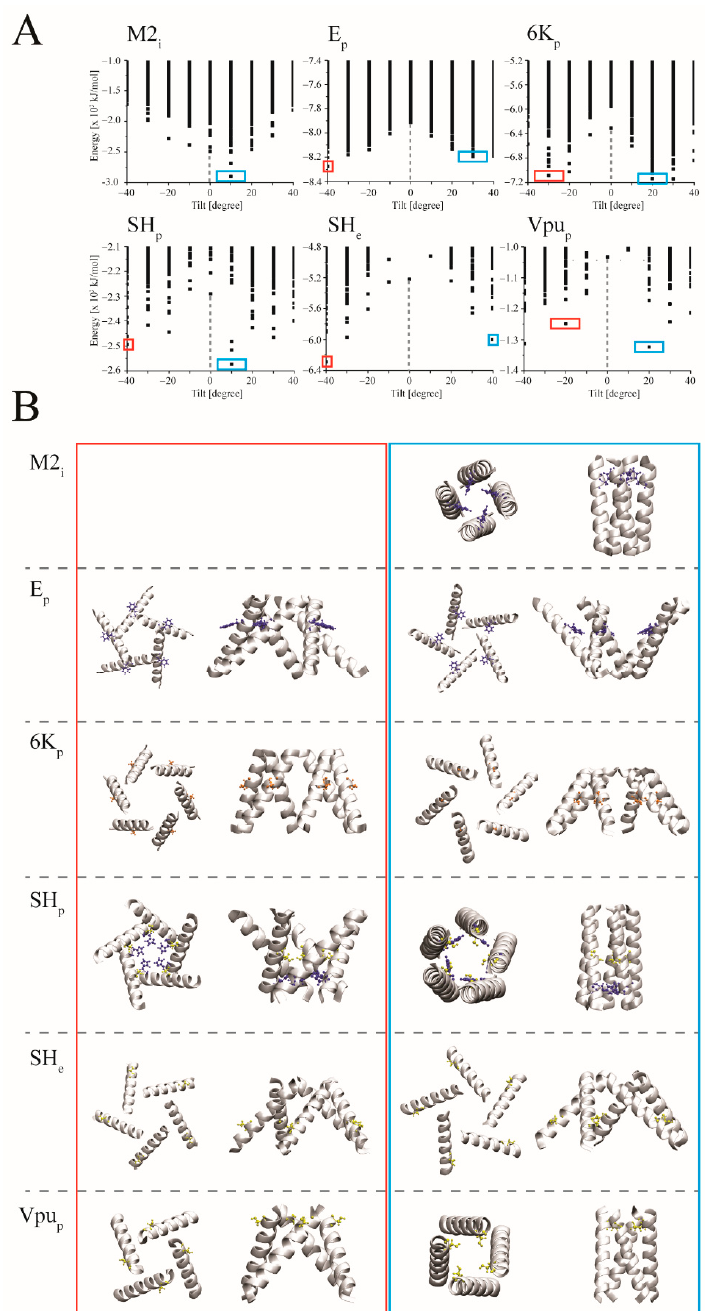
Figure 1. Ranking of the assembled all atom (AA) bundles over the tilt and selected structural models using S1 protocol. ( A ) The estimated binding energies (EBEs) of tetrameric bundles using ideal TMDs of M2 i and Vpu p , the pentameric bundles of E p , SH p , SH e , and the hexameric bundle of 6K p are plotted over the tilt. The grey dashed line marks the EBE for a zero tilt. The blue and red boxes mark minimum energies for energies with tilts larger and lower, respectively, than tilt values with zero tilt. ( B ) Structural models of the respective bundles marked with the red (tilt < 0 tilt) and blue boxes (tilt > 0) in top (from N to C) and side view (cytoplasmic side pointing downwards). The helix- backbone is shown in grey cartoon mode. Side chains mark the following residues: H37 for M2 and F26 for E, as well as A28 for 6K; H22 and S29 for SH p ; S29 only for SH e ; and S24 for